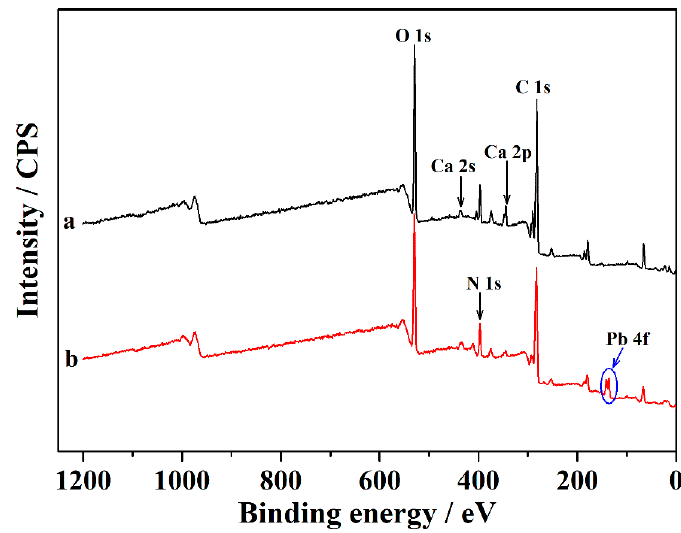
Figure 2. X-ray photoelectron spectrometer (XPS) spectra of sodium alginate-polyacrylamide (Alg–PAM) ( a ) before and ( b ) after Pb 2+ adsorption.